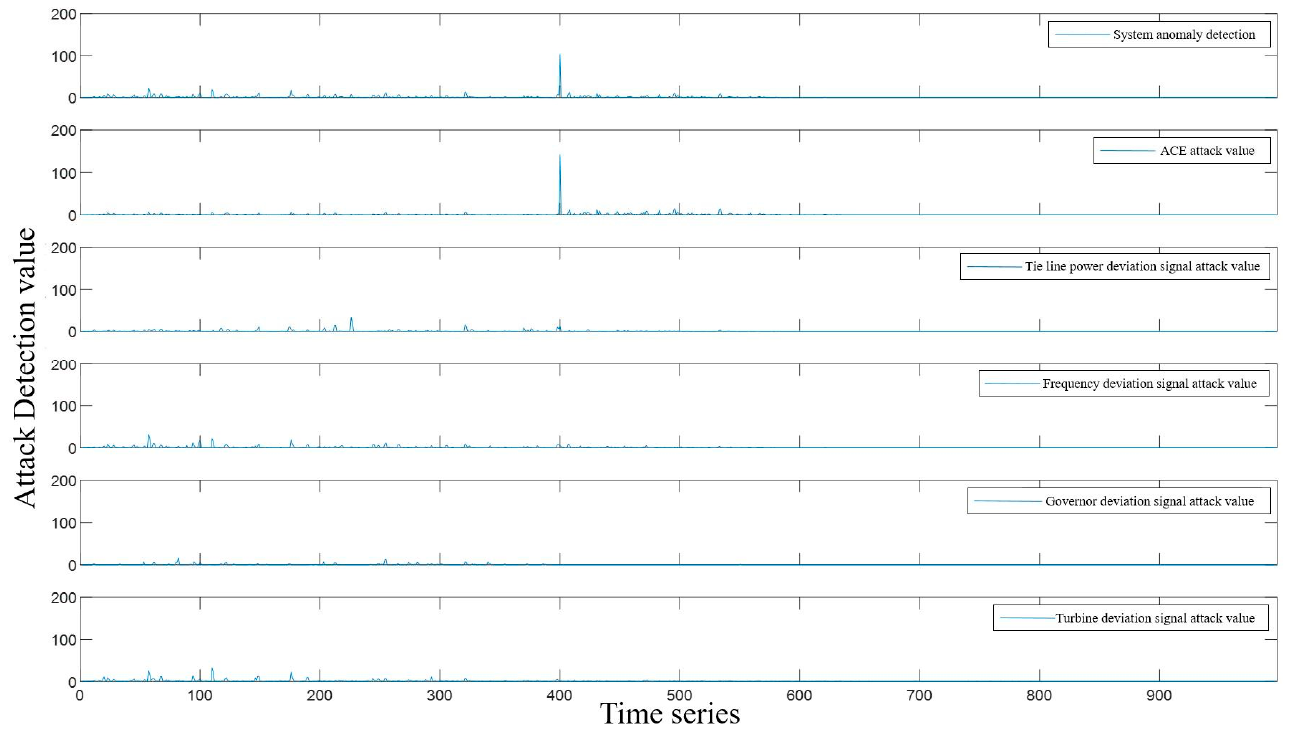
14 of 23 Figure 6. ACE Single-State Variable Attack Probability Detection Value.